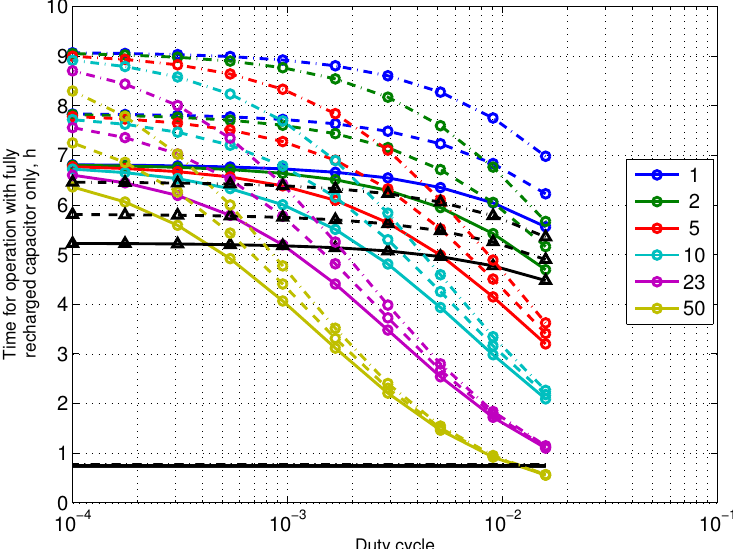
Figure 9. When M t = 1 and M r = 1, time for operation with capacitor ( C s = 0.35 F) only. Non-WuR in black (without triangles), passive WuR in colors indicating number of nodes for different host duty cycles per node ( β (cid:48) w ). Semi-passive WuR in black with triangles. Line type indicates used SC